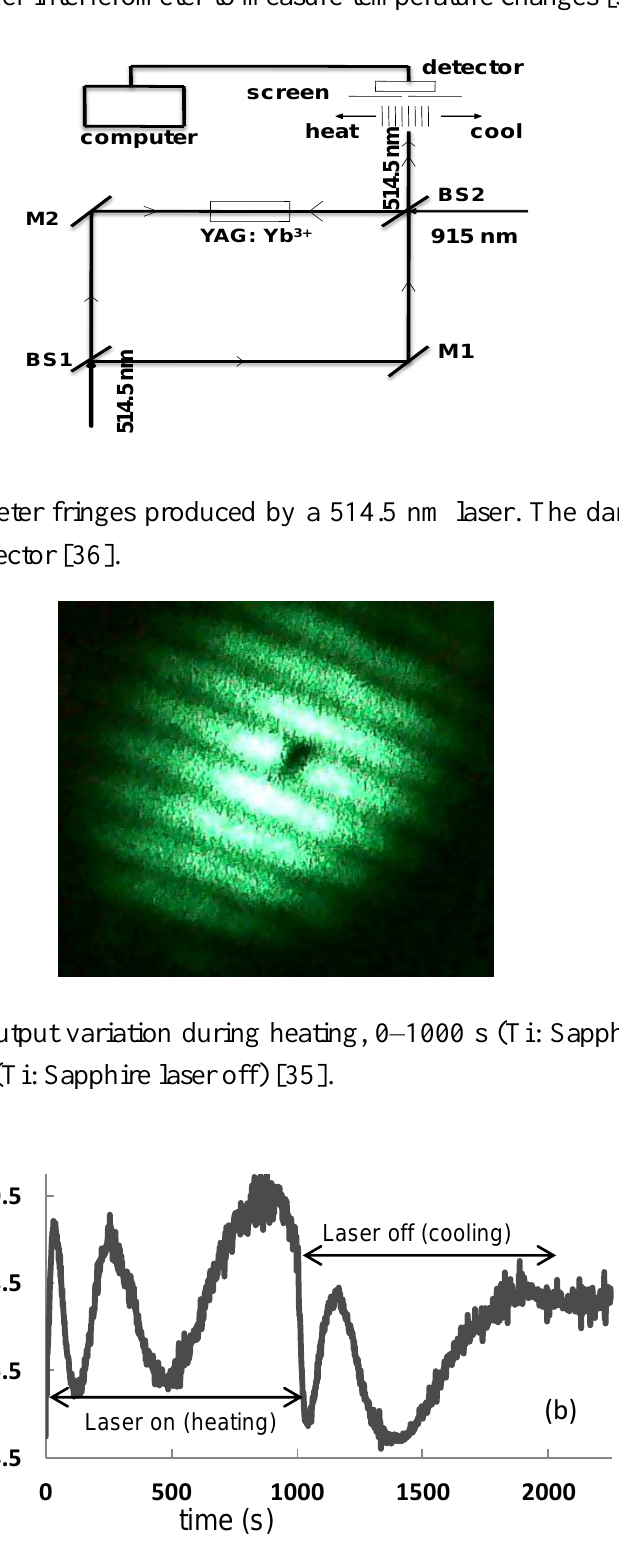
Figure 12. A 915 nm laser beam heats the YAG: Yb 3+ sample. A 514.5 nm beam was used to setup a Mach-Zehnder interferometer to measure temperature changes [35].